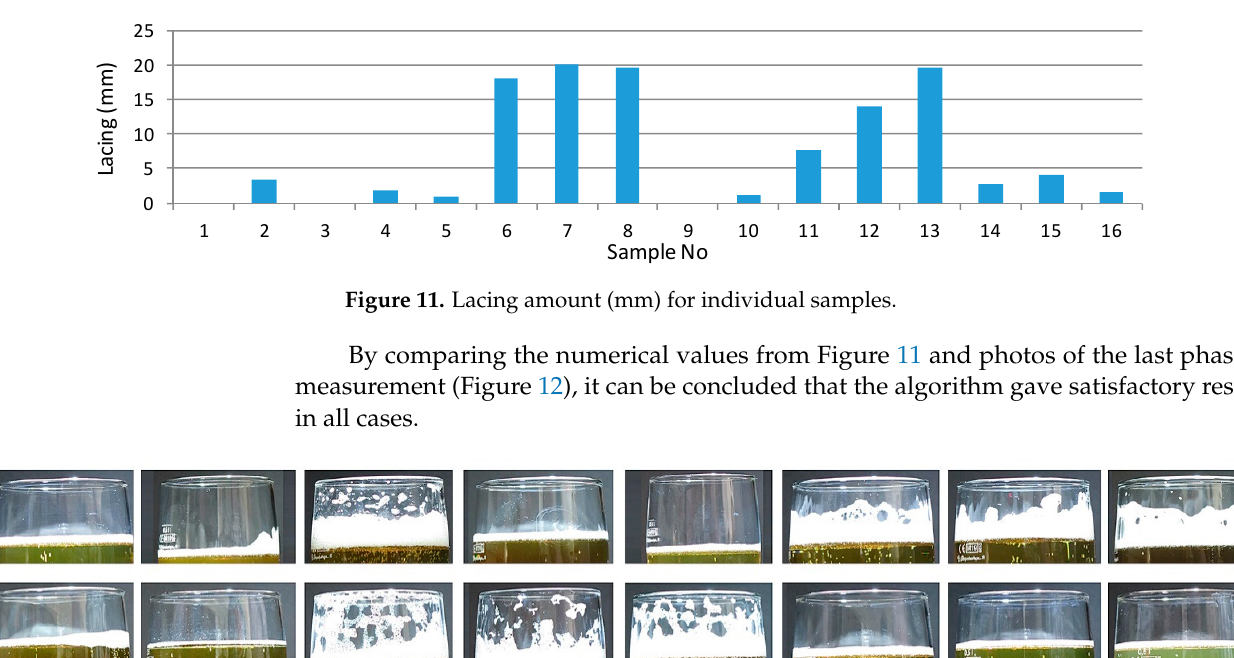
Figure 10. Algorithm used for beer foam analysis and determination of lacing.